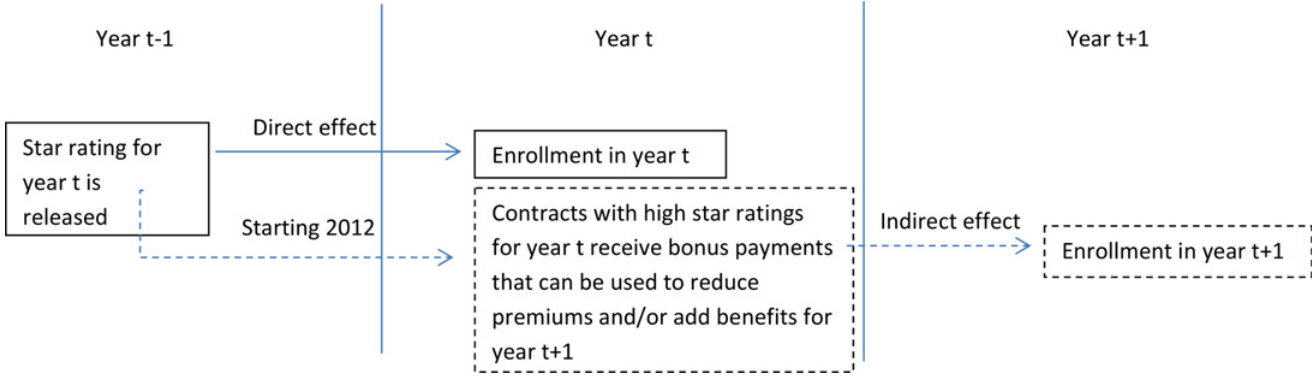
Fig 2. Hypothesized Direct and Indirect Relationships Between MAPD Contract Star Ratings and